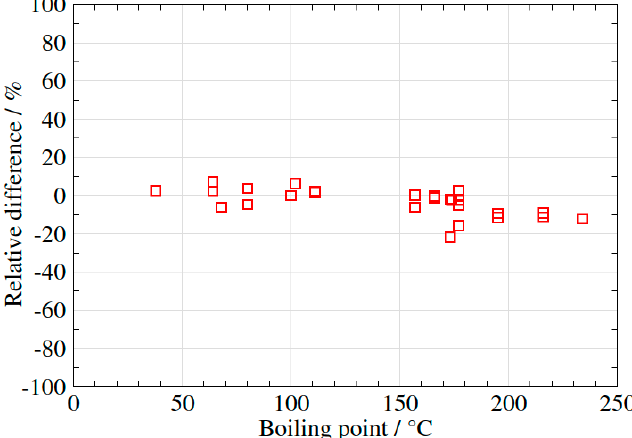
Figure 7. Difference in VOCs concentrations measured with the sampling pump method versus the EasyVOC method (water vapour <0.8 vol-%).